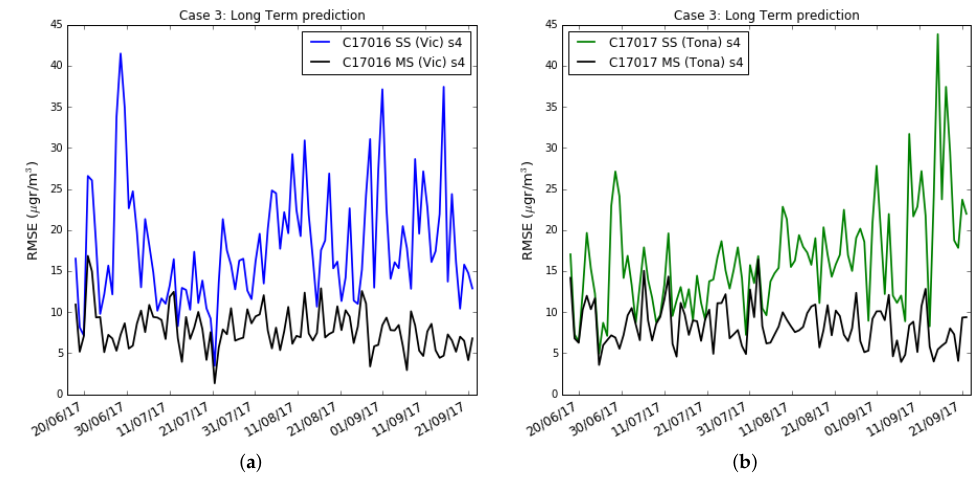
Figure 15. Case 3: Test RMSE in per day basis with training set of 3 weeks, single-scale versus